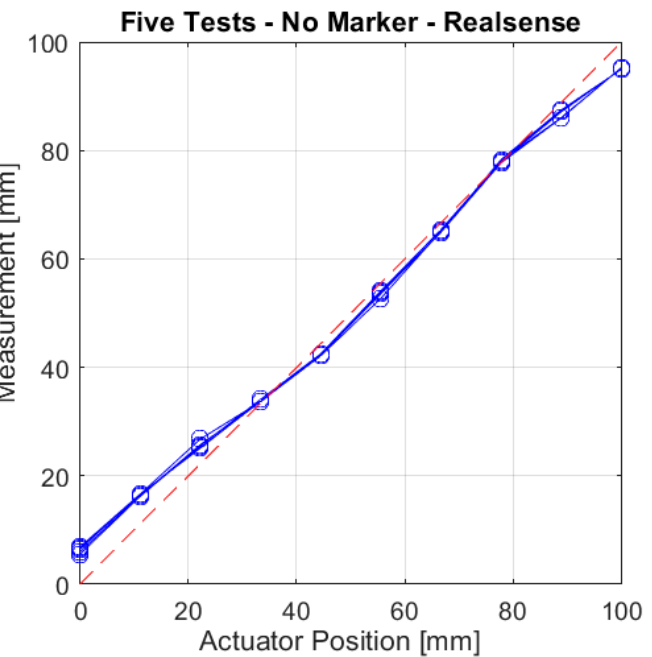
Figure 4. Experimental values measured through vision device (blue circle line) compared with target trend line (red dashed line).